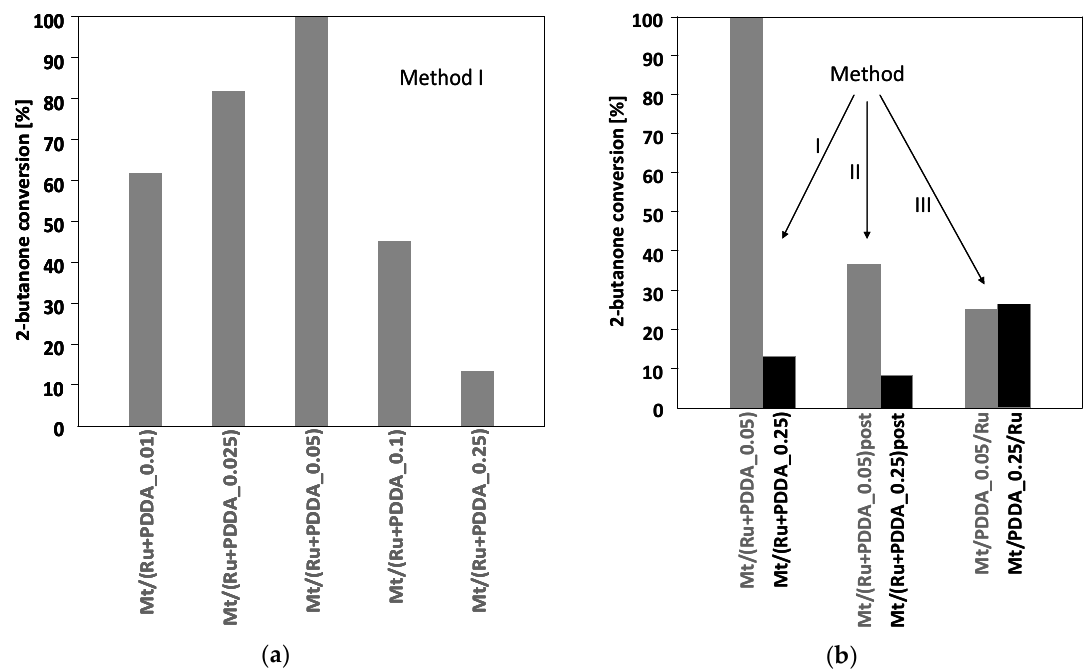
Figure 9. ( a ) Catalytic activity in 2-butanone hydrogenation of Mt/(Ru + PDDA_ x ) composites; ( b ) comparison of catalytic activity of composites prepared by different methods, for polymer/clay weight ratio of 0.05 and 0.25. In all cases selectivity to 2-butanol is 100%.